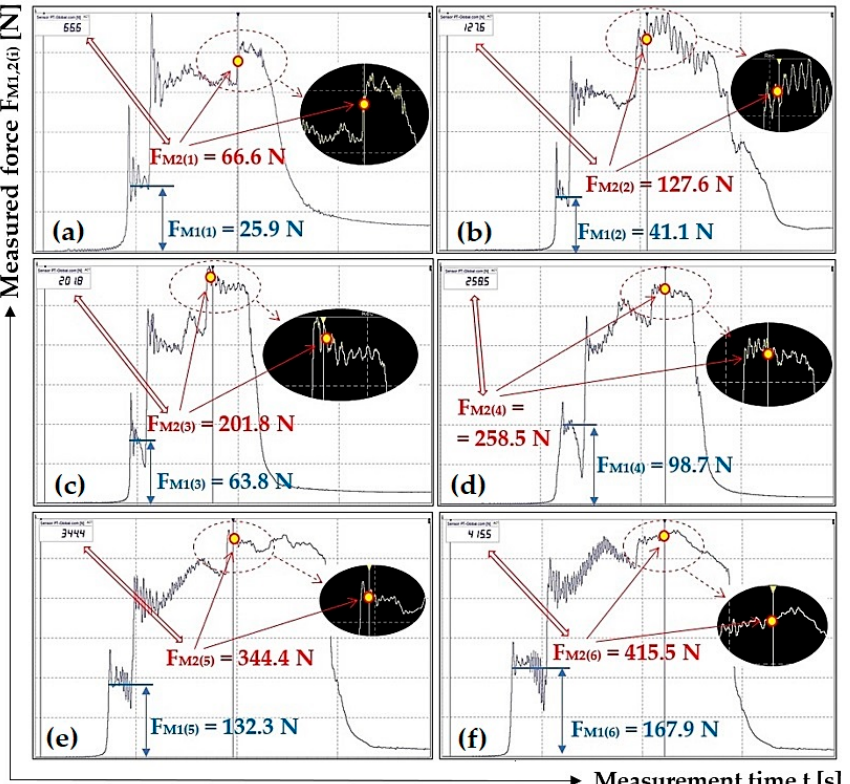
Figure 8. Tensile forces measured using DeweSoft ® software for different load weights at the scraper plough angle of inclination β = 30 deg.